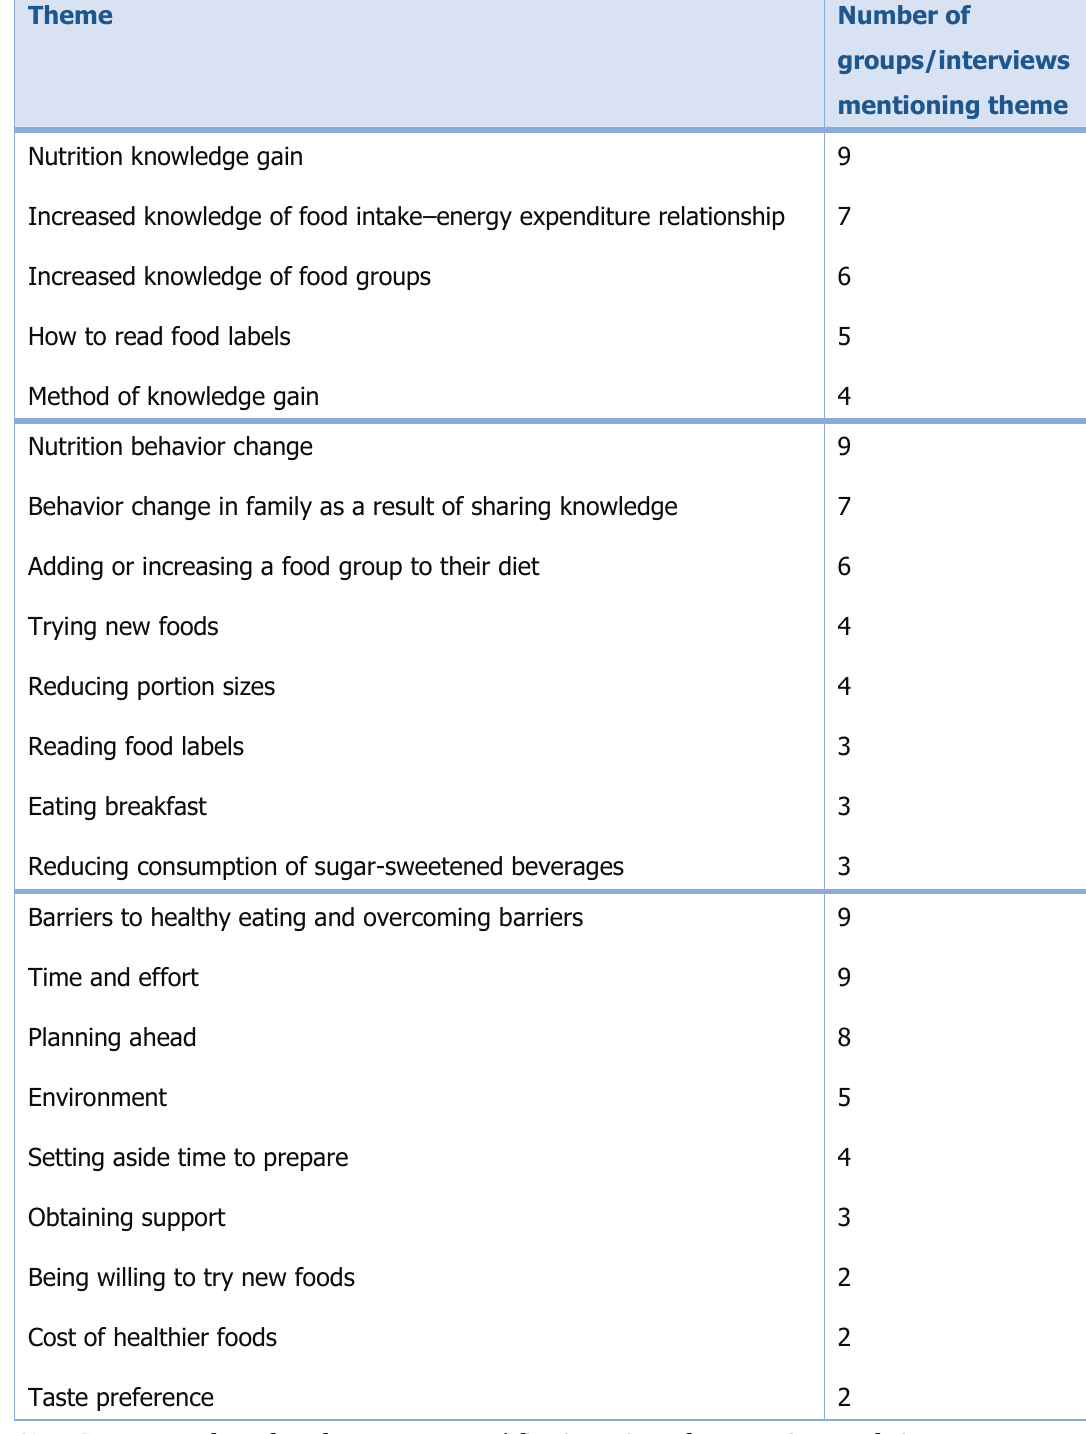
Table 1. Themes Discussed in Focus Groups and